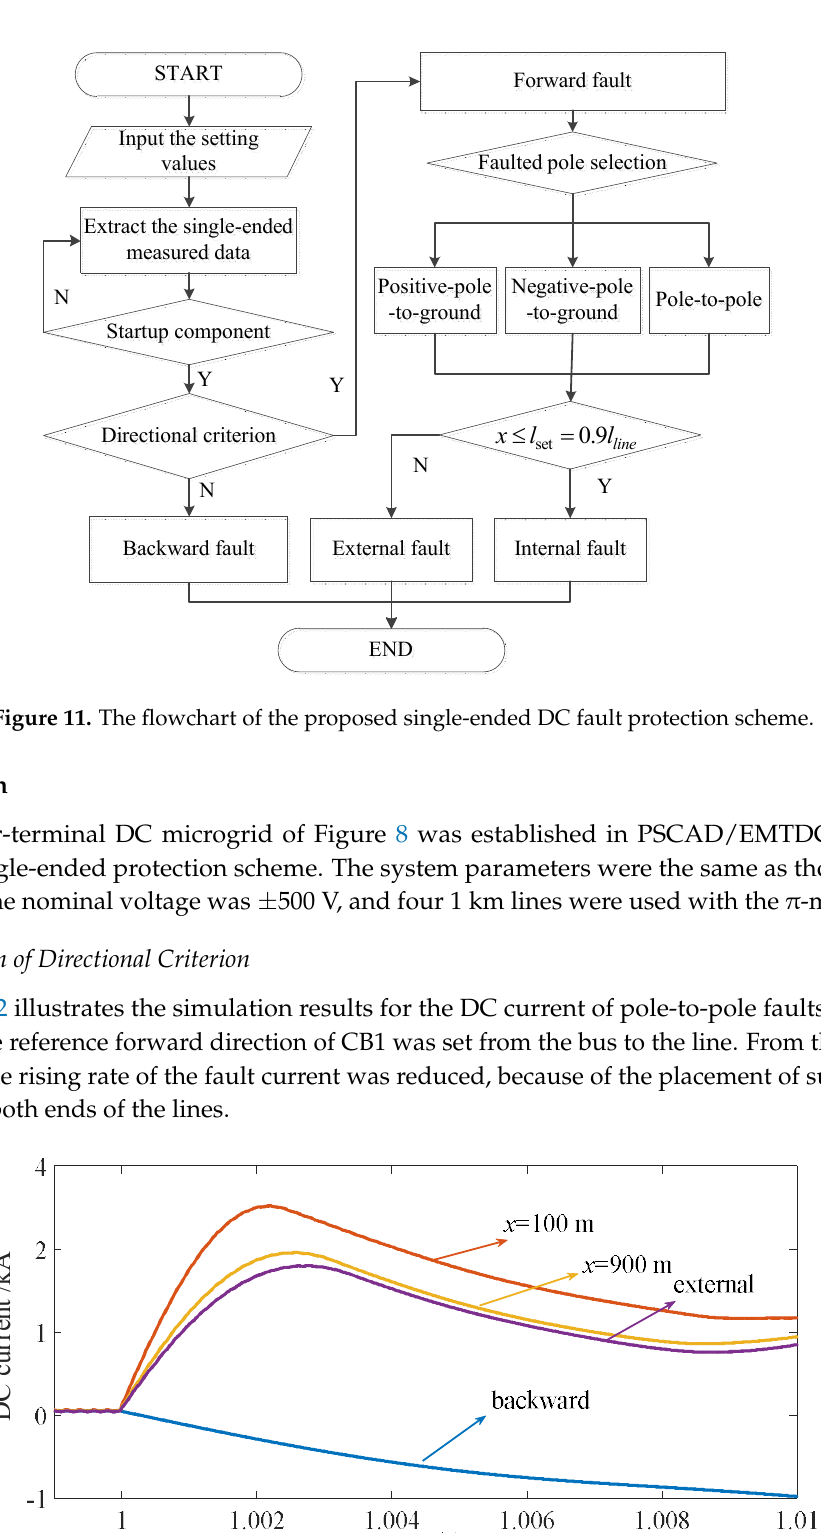
Figure 13. The DC inductor voltage of pole-to-pole faults at different distances . 4.2. Simulation of Faulted Pole Selection The results of the faulted pole selection for CB1 are displayed in Table 1. Here, the internal faults were located on line 12 and the external faults were set on line 24. The fault distances were 100, 500,